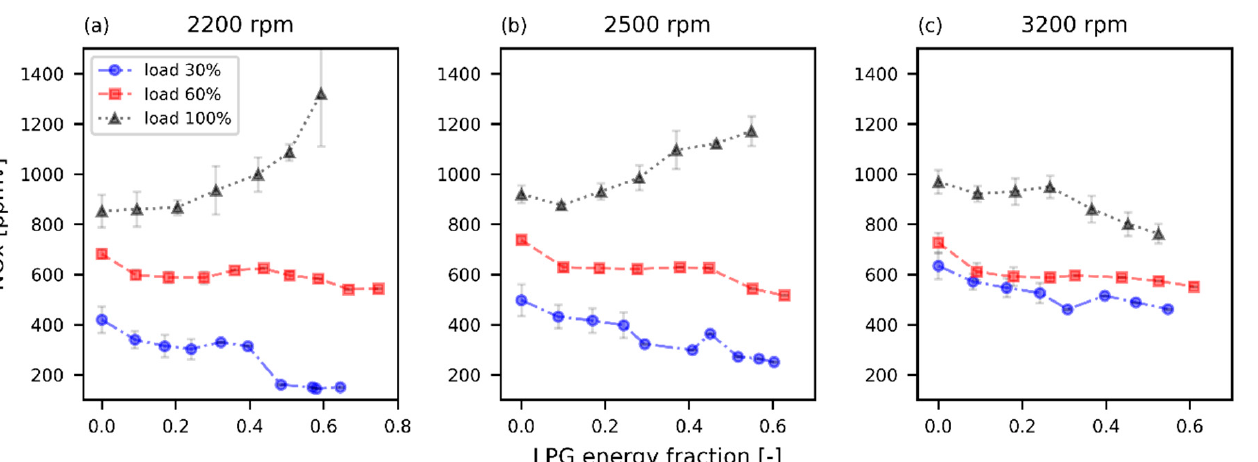
Figure 10. Exhaust gas temperatures v/s LPG energy fraction at ( a ) 2200 rpm, ( b ) 2500 rpm, and ( c ) 3200 rpm. Table 4 highlights the most important findings for gaseous emissions in dual opera- tion. Table 4. Most important findings for gaseous emissions in dual operation. Speed (rpm) Load Level (%) LPG Energy Fraction (%) Equation Ratio (-)